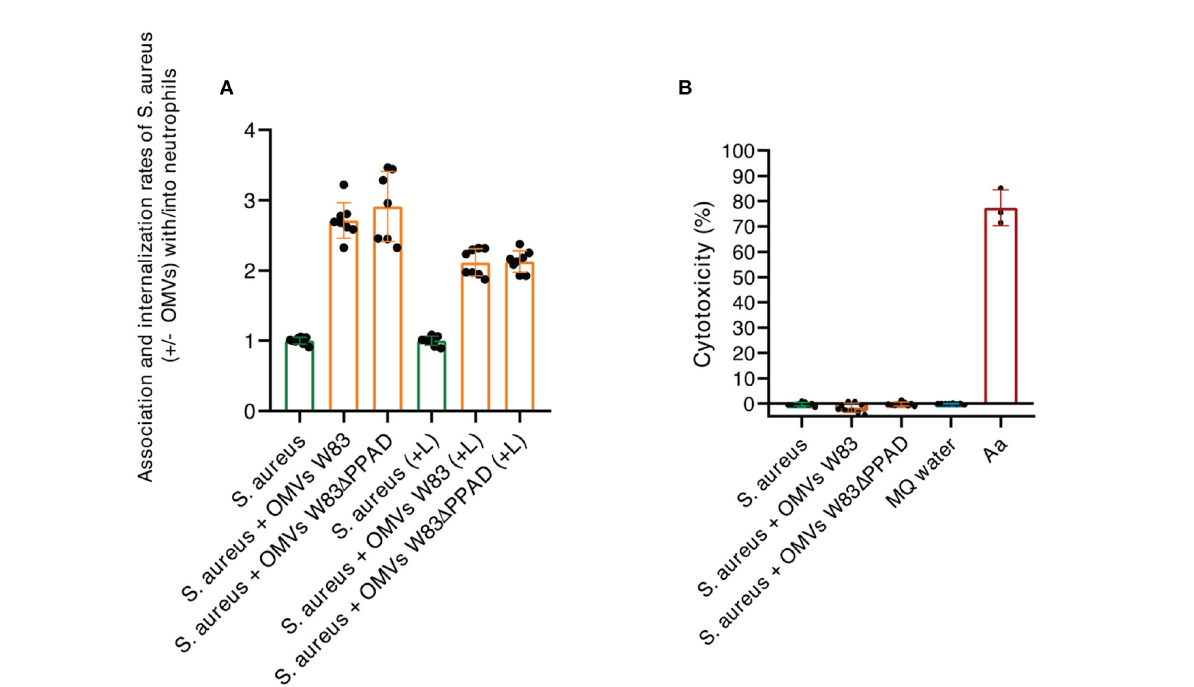
FIGURE6 Characterization of neutrophil internalization of S. aureus upon exposure to P. gingivalis OMVs. (A) Ratios of the association/internalization indices of S. aureus incubated with OMVs and the association/internalization indices of S. aureus incubated without OMVs. L, lysostaphin. (B) Percentage of neutrophil killing as determined by LDH release. Neutrophils were challenged with S. aureus in the presence or absence of OMVs from P. gingivalis W83 or W83 1 PPAD. A. actinomycetemcomitans 30R (Aa) was used as a positive control for cytotoxicity and MilliQ water as a negative control for spontaneous LDH release from the neutrophils. The mean and standard deviations were calculated from three biological replicates and two technical